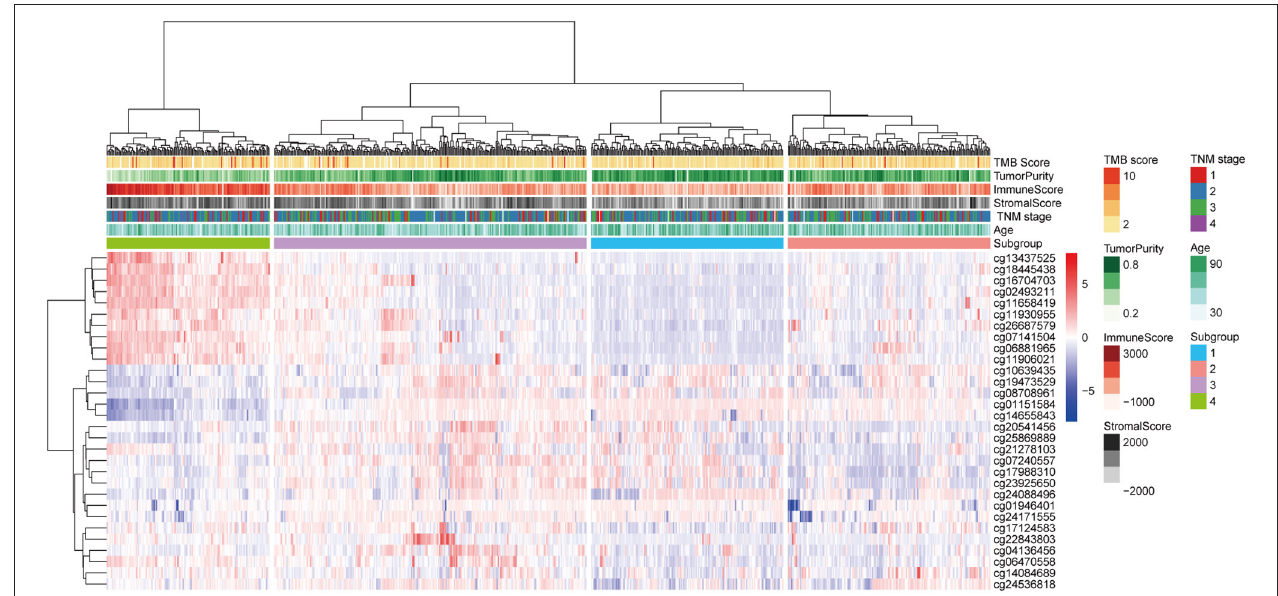
FIGURE 4 | Heatmap showing the distribution of the beta values of the 30 IC-SHMSs with prognostic value between the four